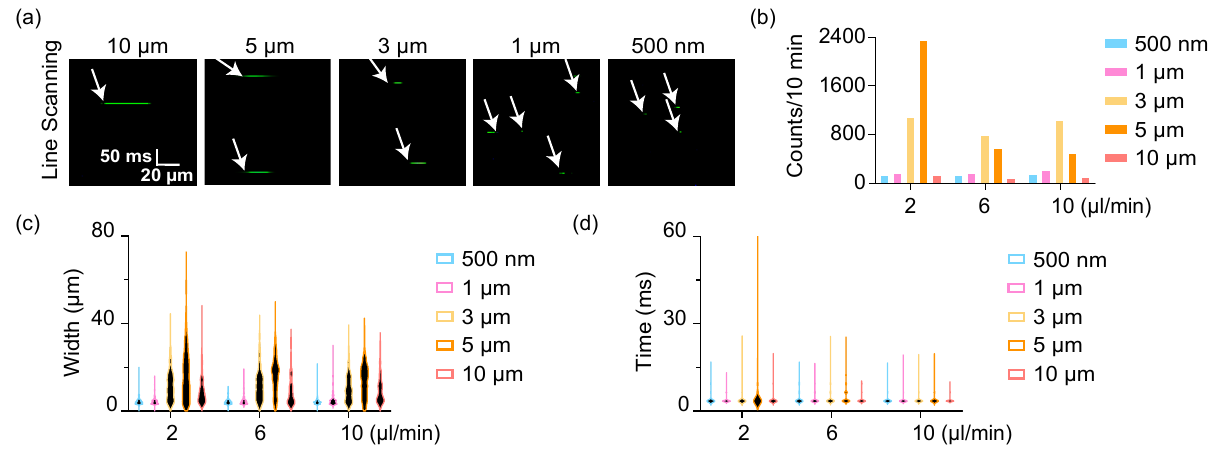
Figure 2. Detection of flowing microbeads by line scanning. ( a ) The time-lapse imaging of flowing microbeads. The images are stacks of the fluorescence of each line scanning. ( b ) The detection counts of each microbeads. ( c ) The width of microbeads directly indicated by the fluorescence in ( a ). ( d ) The scanning time of each microbeads.